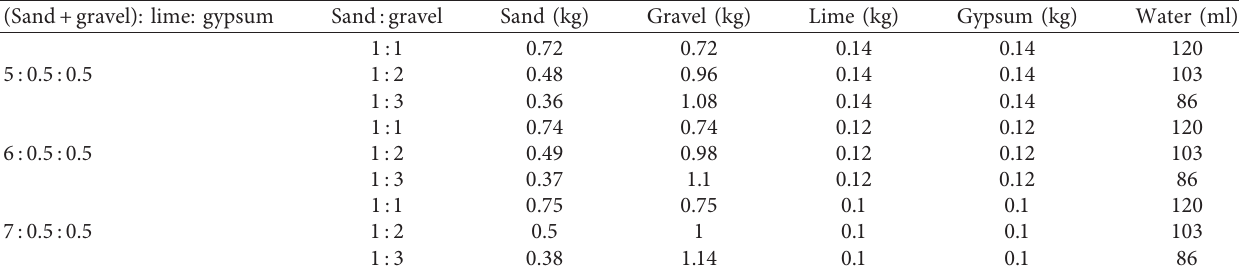
Table 2: The first test block matching